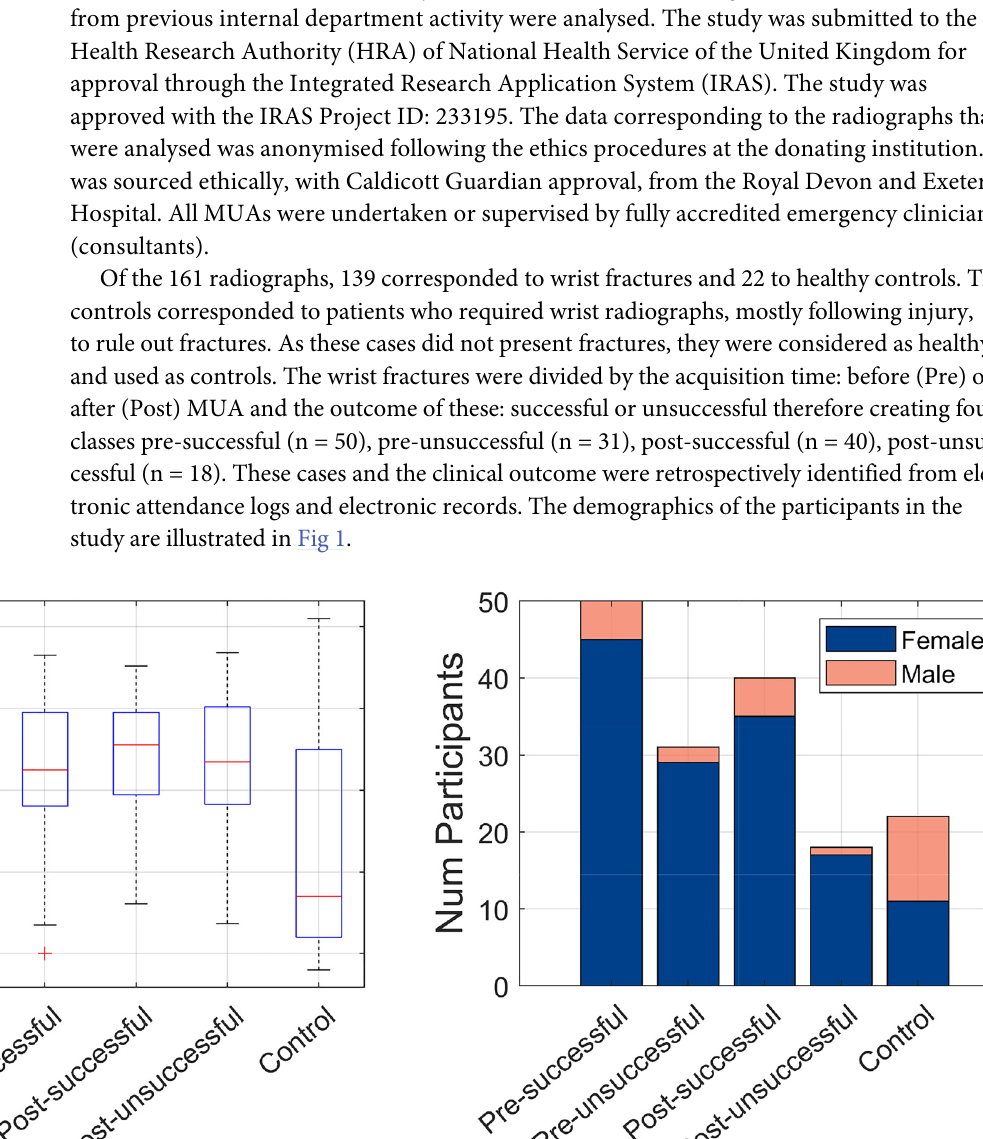
PLOS ONE | https://doi.org/10.1371/journal.pone.0238926 September 14,